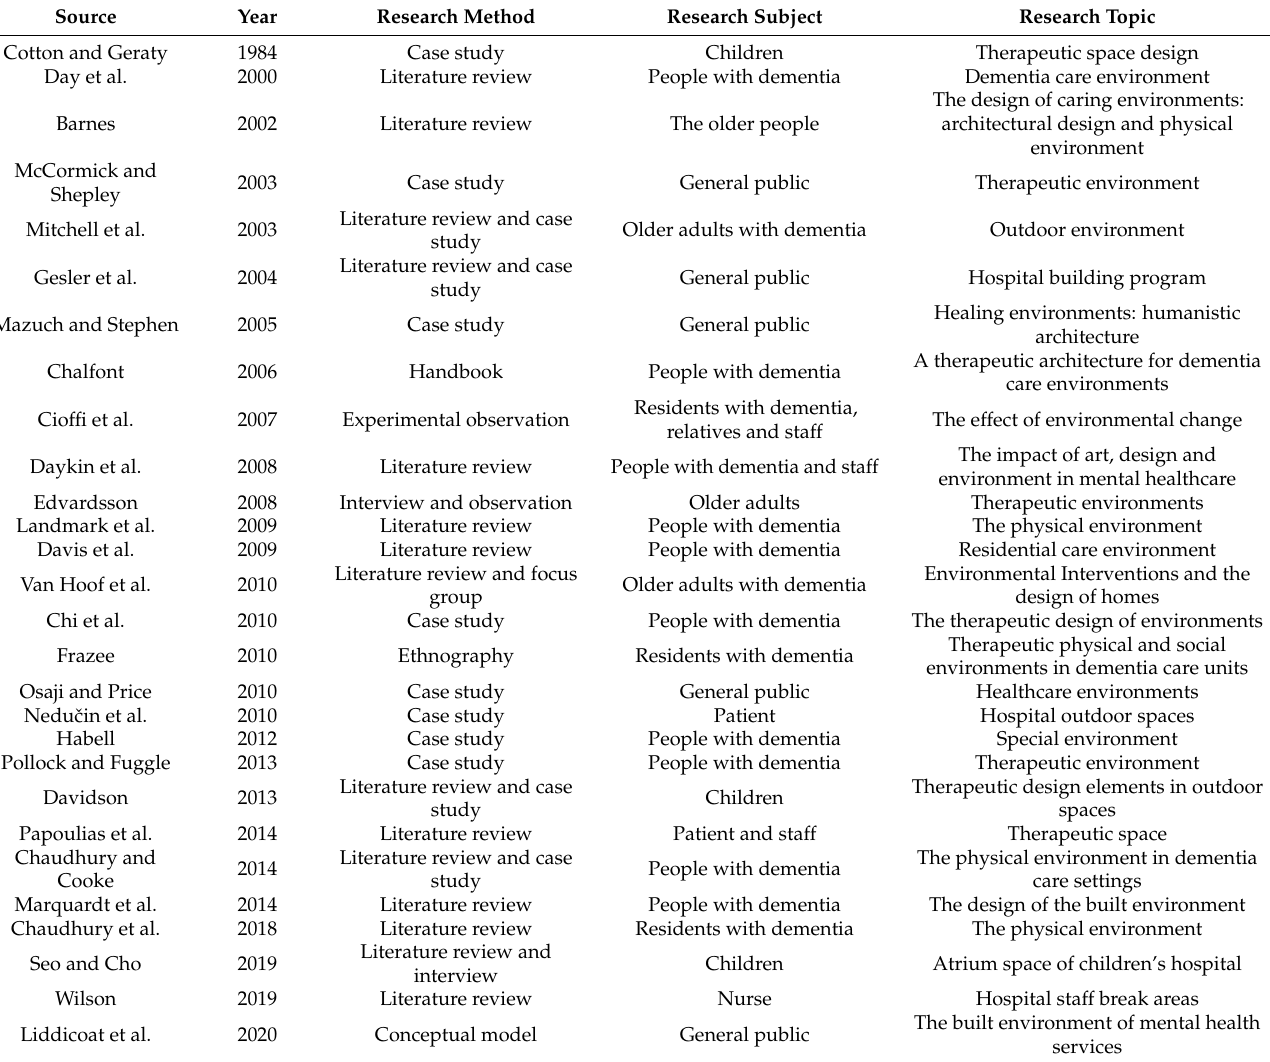
Table 1. Research on the application of TD in the fields of environment, architecture and